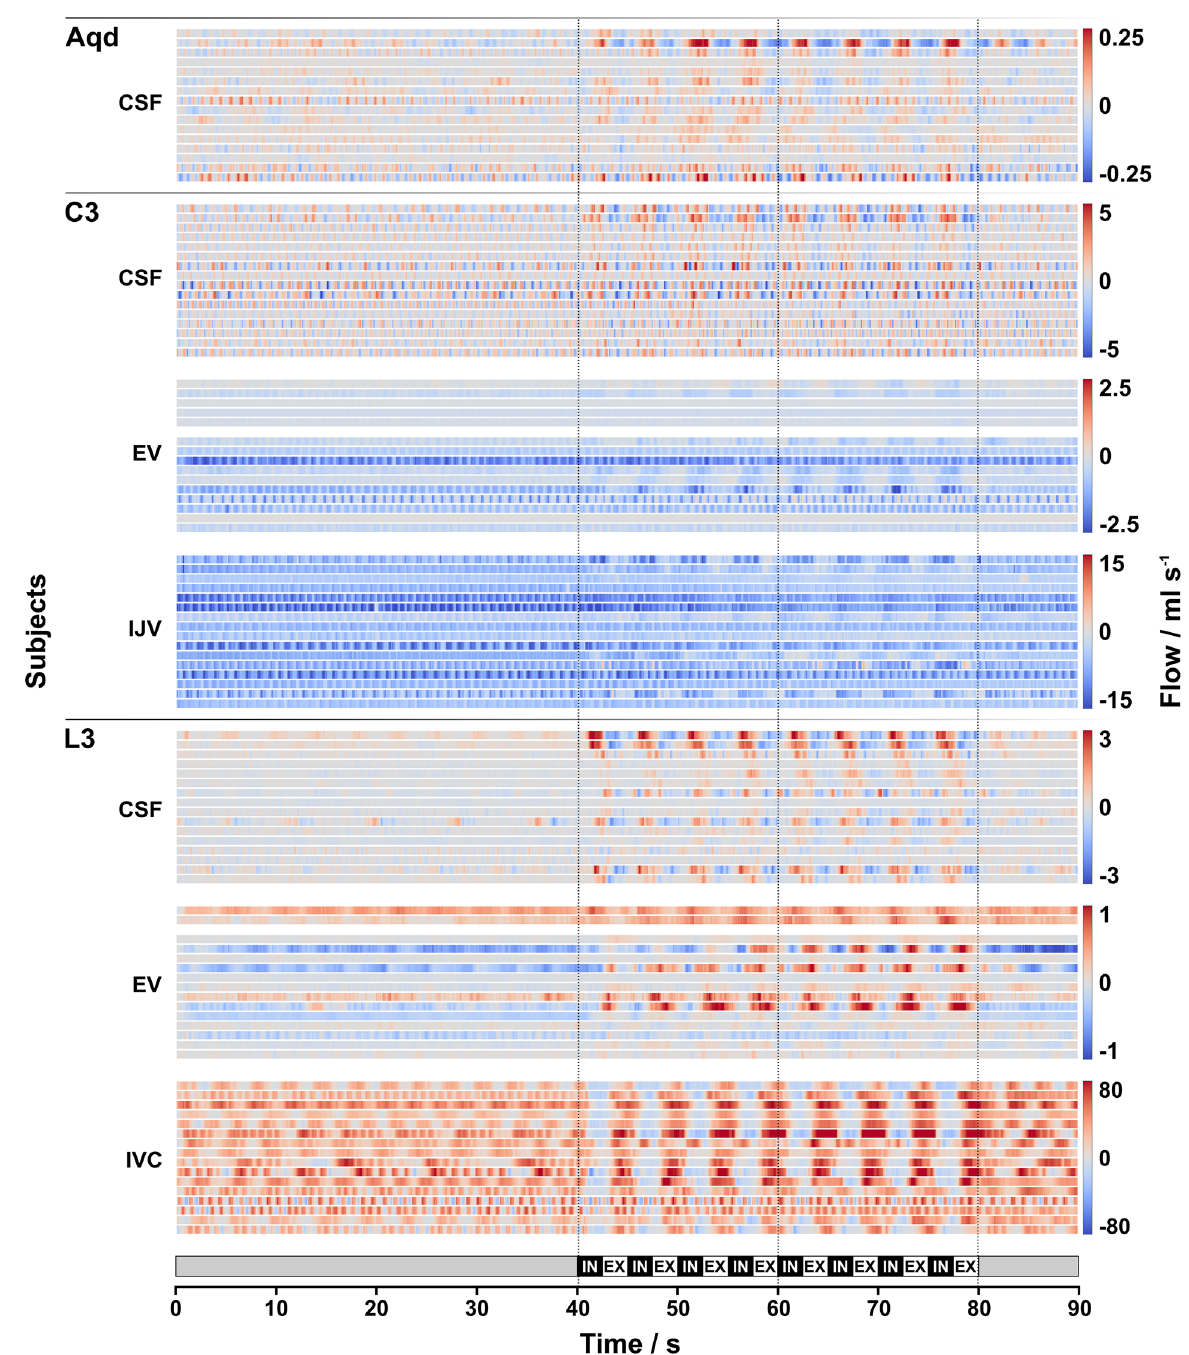
Figure 2. Individual CSF and venous flow. Color-coded flow rates (ml s −1 ) of all 16 subjects in 16 horizontal lines for each ROI during 90 s breathing protocol (bottom). Vertical lines mark start, middle and end of forced breathing. Note the different scaling for the various ROIs. Normal breathing (0–40 s): low CSF flow (blue = downward; red = upward) is regulated by cardiac pulsation (e.g., in Aqd and L3). Venous blood shows steady downward flow in EV and IJV with cardiac pulsatility. IVC flow is predominantly in upward direction with cardiac and respiratory influences (e.g., #1, #4, #5). Low flow at L3-EV is variable between subjects (e.g., opposite directionality between #10 and #5). Forced breathing (40–80 s): CSF and venous flow synchronized to respiration. During IN CSF moves predominantly upwards (various red shades), downward venous flow in C3-EV and IJV is modulated by IN (darker blue). Upward flow in IVC ceases or reverses (blue). During EX downward CSF movement (blue) prevails at all locations, venous flow decreases (lighter blue) at C3 and resumes upward directionality in IVC at L3 (red). Flow in L3-EV shows greater variability, however, respiratory modulations are observable (e.g. opposite behavior in subject #1 compared to #2). Normal breathing (80–90 s): rapid return of CSF and blood flow to the initial pattern. Aqd = aqueduct, C3 = cervical level 3, L3 = lumbar level 3, EV = epidural veins, IJV = internal jugular vein, IVC = inferior vena cava, IN = inspiration, EX =